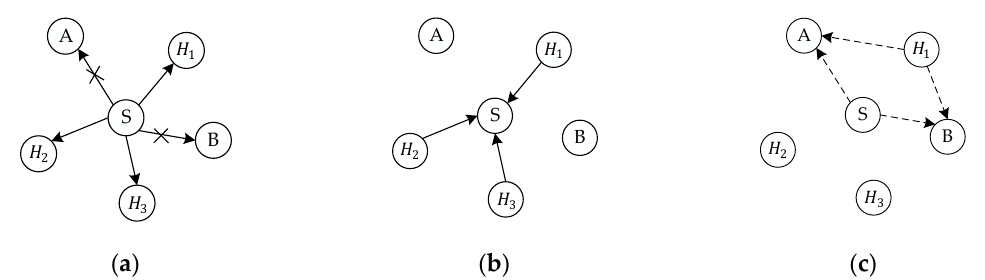
Figure 1. Frame structure. Frame information ⋯ Figure 2. Packet structure. Several helpers are selected to rebroadcast the packet to the failed nodes with the source node cooperatively. Thus, they form a multiple-input multiple-output (MIMO) system. Here, we do not consider coding gain and only focus on power gain of the cooperative MIMO. Then, the MIMO transmission can be seen as several multiple-input single-output (MISO) transmissions. Assuming a binary phase-shift keying (BPSK) modulation scheme, the average bit error rate (BER) in a Rayleigh fading channel for a maximal-ratio-combing (MRC) receiver with m-branch diversity is given by [31]: 𝑝 (cid:3029) (cid:3364)(cid:3364)(cid:3364)(𝑟̅, 𝑚) = 1 𝜋 (cid:3505) (cid:3436)1 +